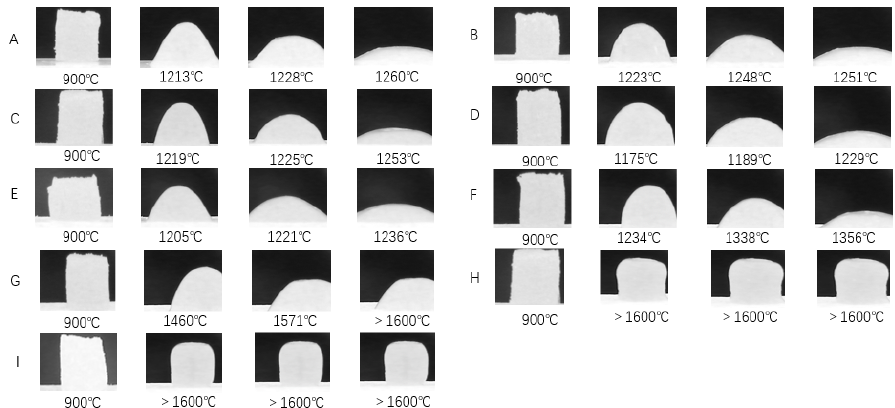
Figure 5. High-temperature microscopic images and characteristic temperatures of the samples: ( A ) fly ash 1 imitation basalt compound; ( B ) coal gangue imitation basalt compound; ( C ) fly ash 2 imitation basalt compound; ( D ) basalt; ( E ) red mud imitation basalt compound; ( F ) red mud; ( G ) fly ash 1; ( H ) coal gangue; ( I ) fly ash 2.